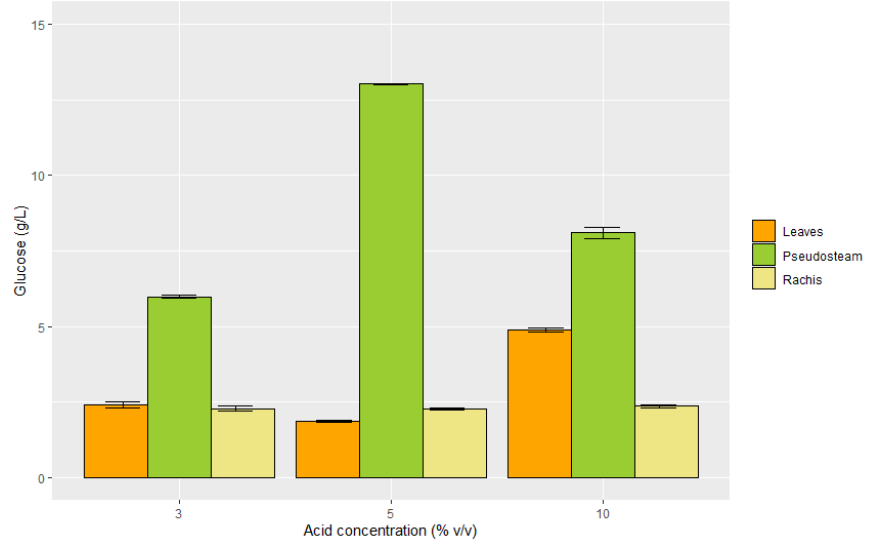
Figure 4. Hydrolysis Results, temperature 100 °C, 20 min .